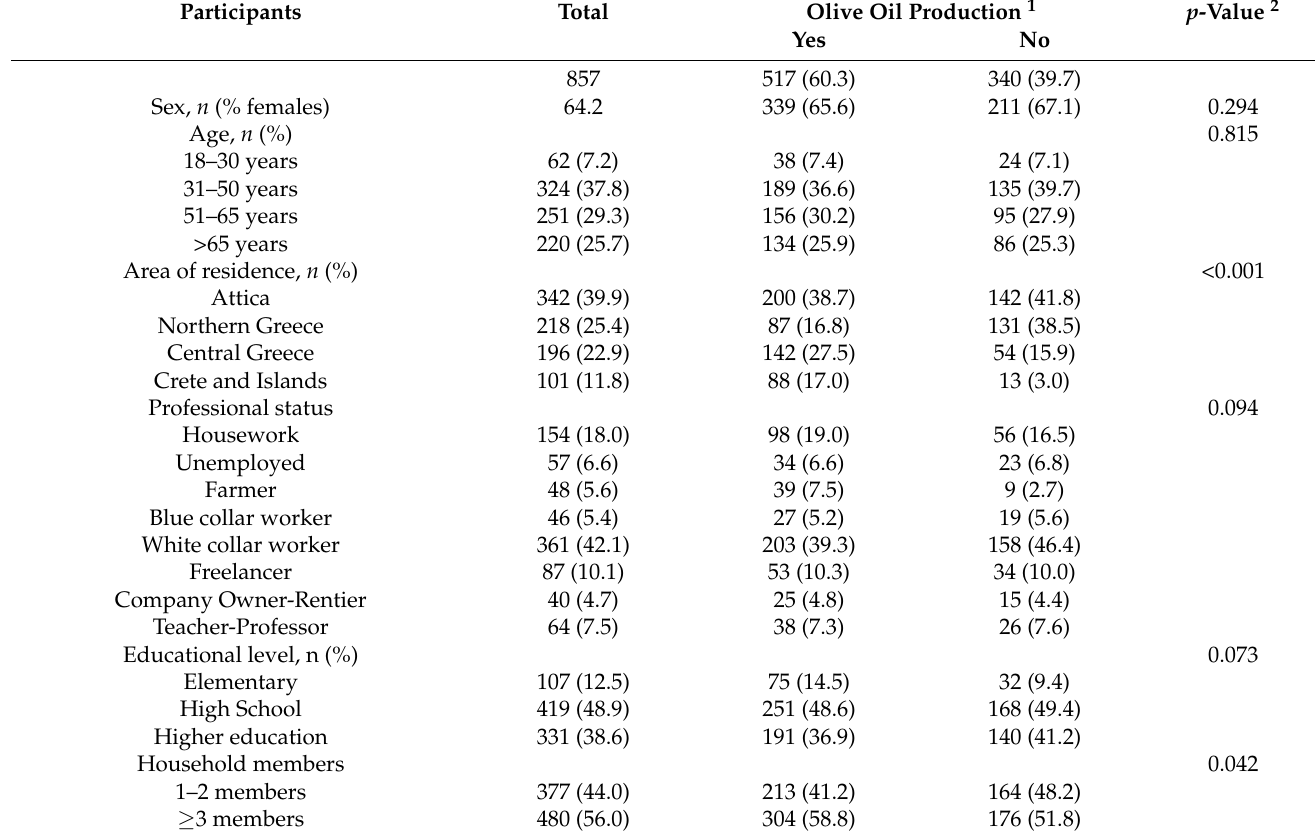
Table 1. Main characteristics of study participants in total ( n = 857) and by olive oil